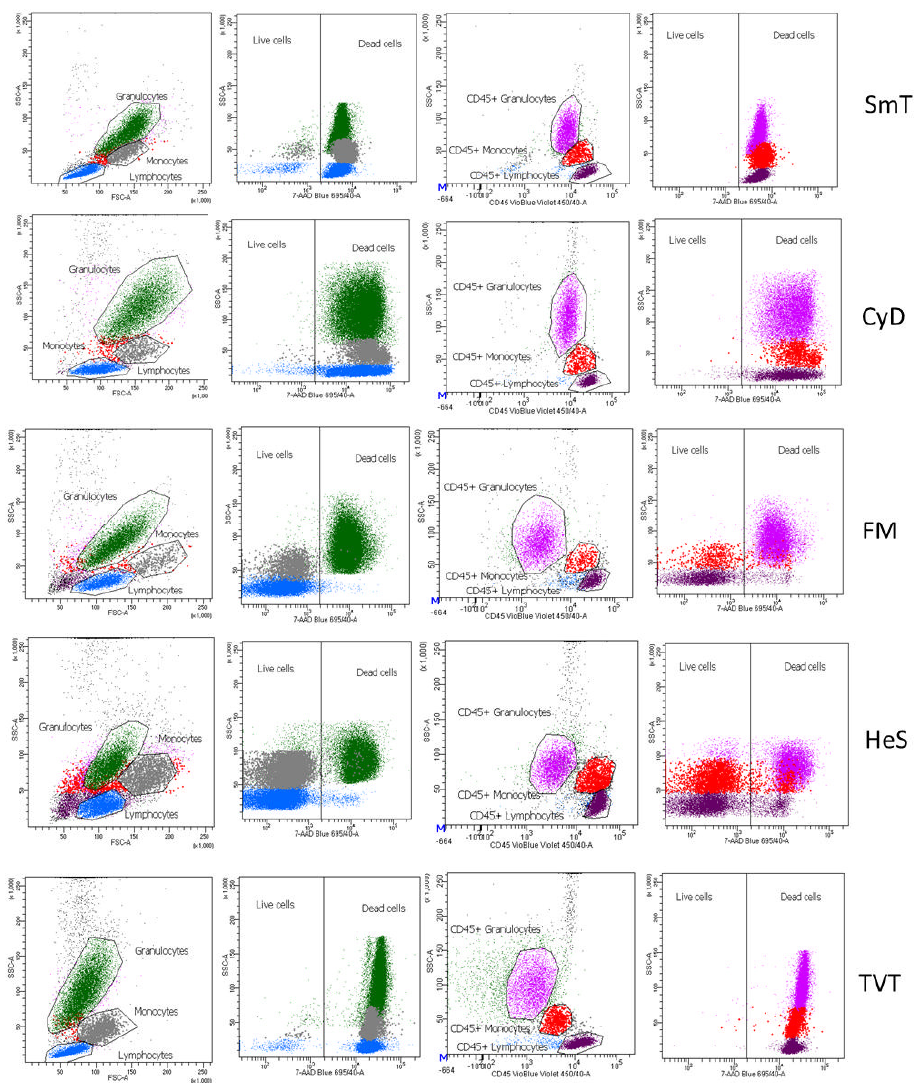
Figure 9. Cell viability after cryopreservation. Leukocyte viability was determined by 7-aminoactimicyn-D negativity in morphologically gated granulocytes (green), monocytes (gray), and lymphocytes (blue); and in CD45+ granulocytes (pink), CD45+ monocytes (red), and CD45+ lymphocytes (purple). A representative sample staining for each method is shown.